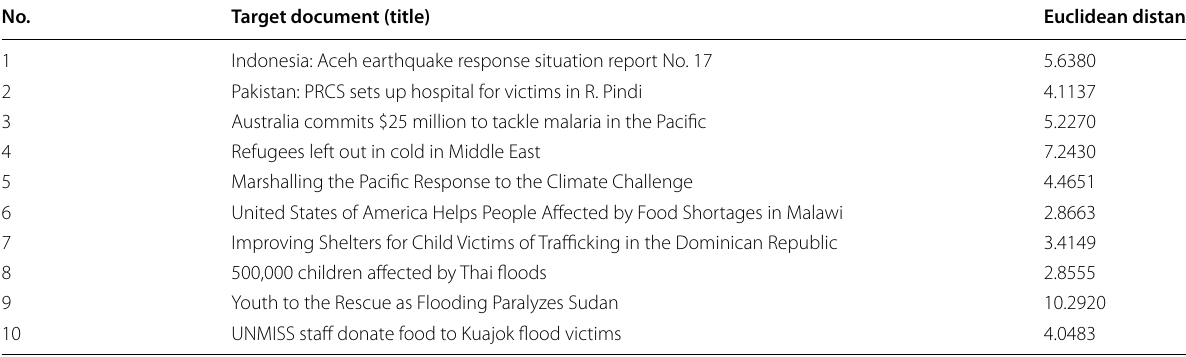
Table 3 Target documents retrieved in document retrieval task